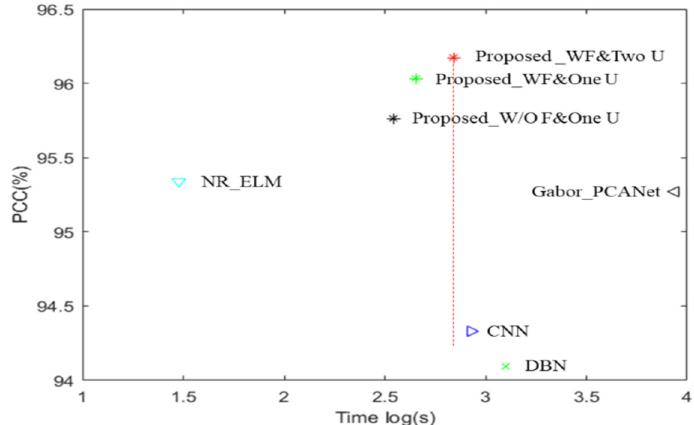
Figure 26. Comparison of the computational time and